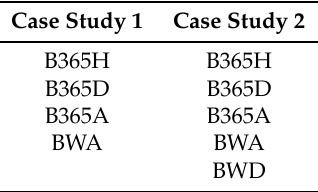
Table 6. The final features of the proposed models excluding weather features.